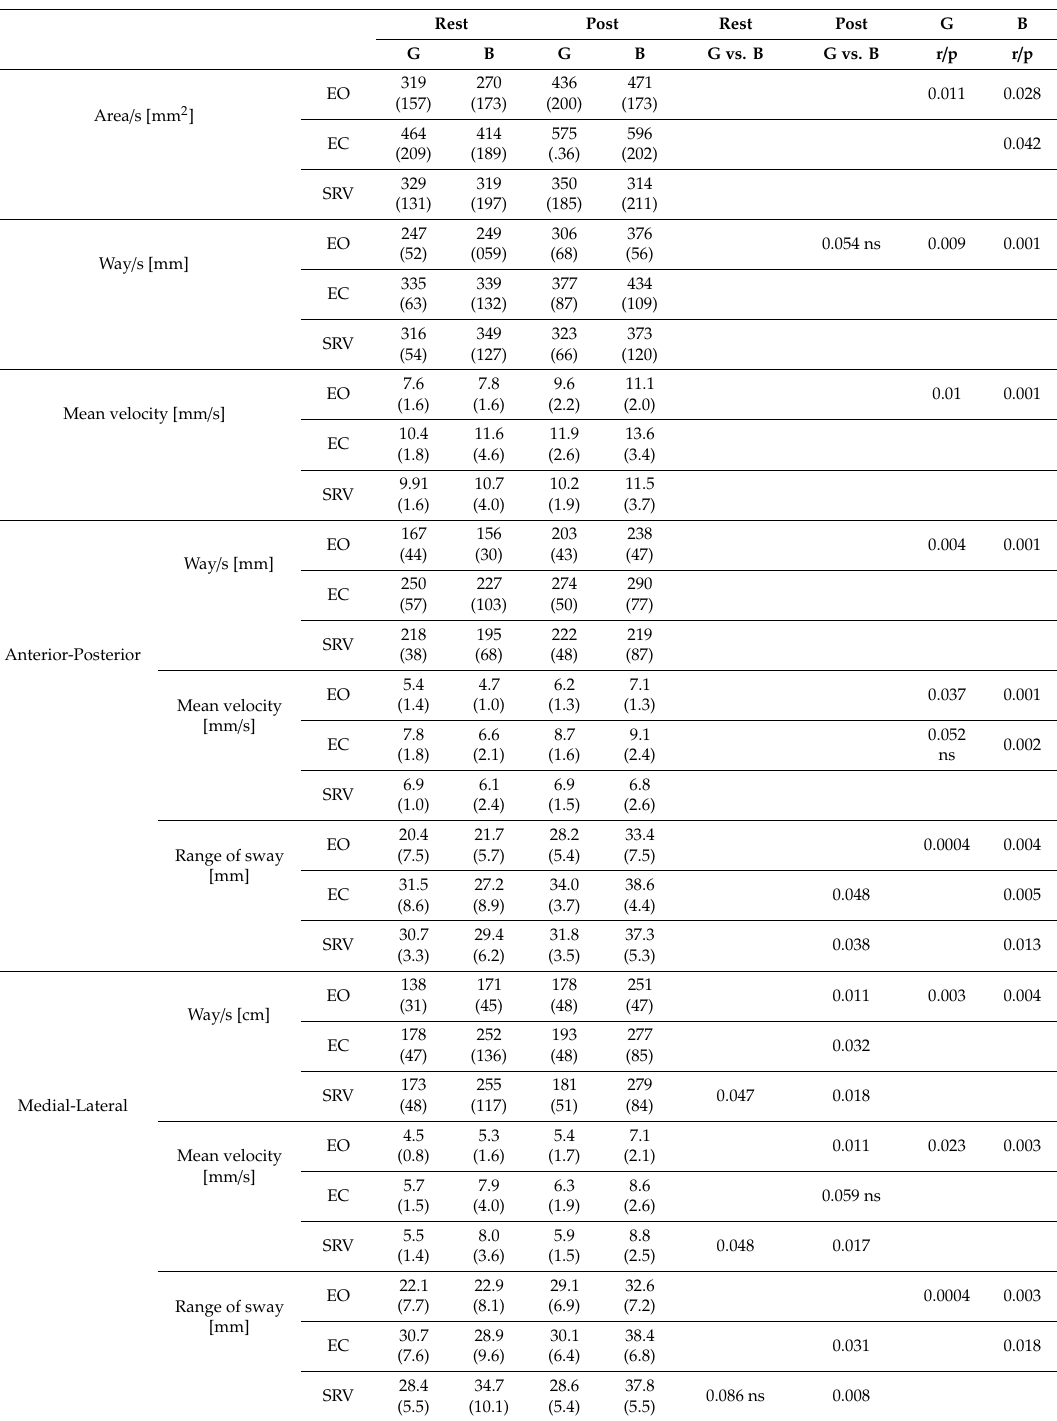
Table 3. Postural stability parameters (mean (SD) in rest and after WAnT condition for girls and boys. Results for Student t test for intersex comparison and for e ff ort